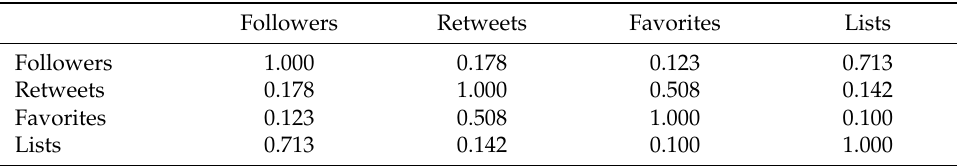
Table 6. Kendall’s Correlation between Influence Ranks.